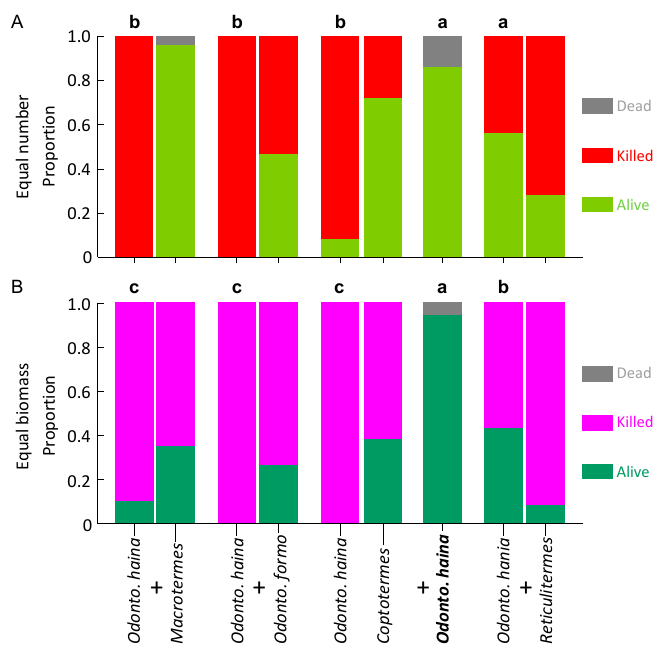
Figure 4. Survival of Odontotermes hainanensis in laboratory aggression experiments. The control appears as a single column as it contains one species, whereas paired species treatments are paired columns, the O. hainanensis on the left of each pair. Columns surmounted by different letters signify significantly different proportion survival (Bonferroni corrected pairwise comparisons) for O. hainanensis . ( A ) Equal number of termites; ( B ) Equal biomass of termites. Insects 2018 , 9 , x